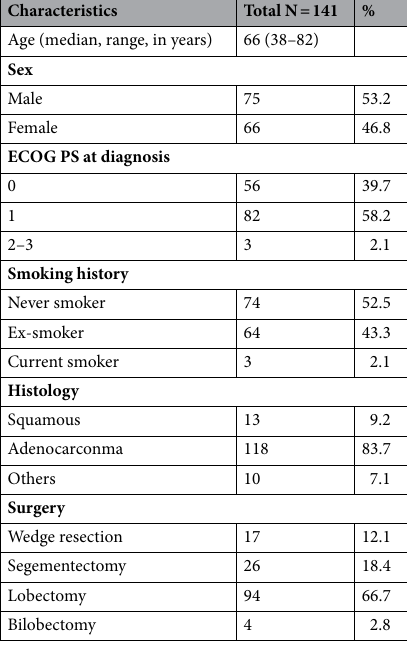
Table 1. Clinical information of 141 NSCLC patients. ECOG PS Easter Cooperative Oncology Group Performance